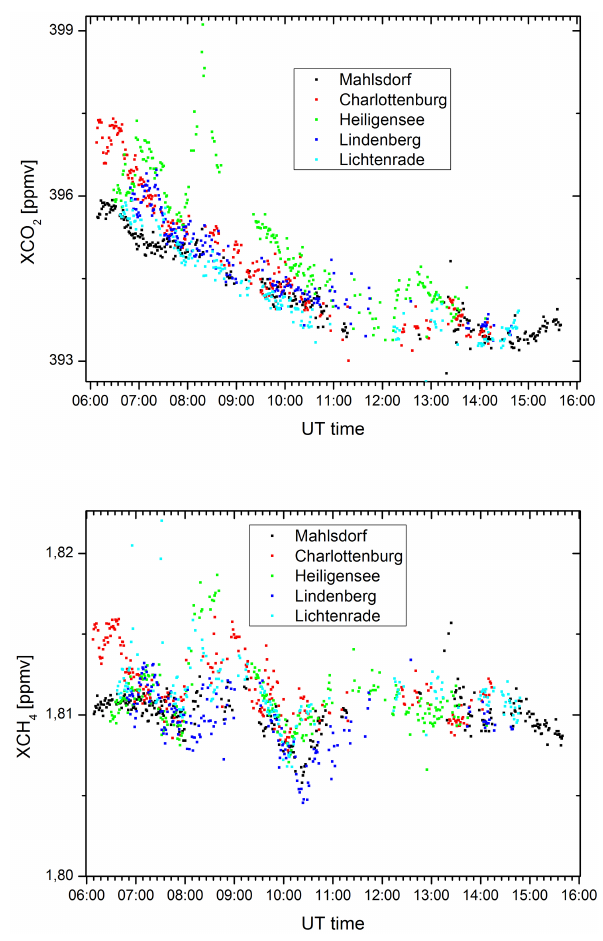
Figure 5. Observed variability of XCH 4 and XCO 2 during 27 June 2014.